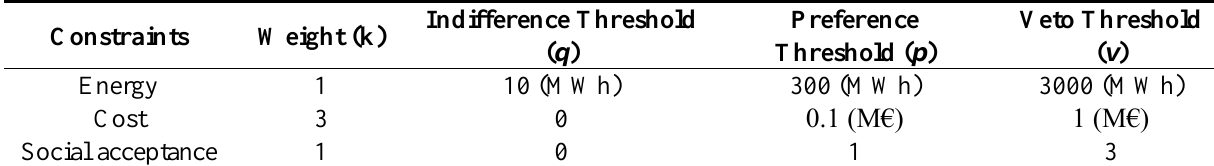
Table 3. Threshold values and weights.